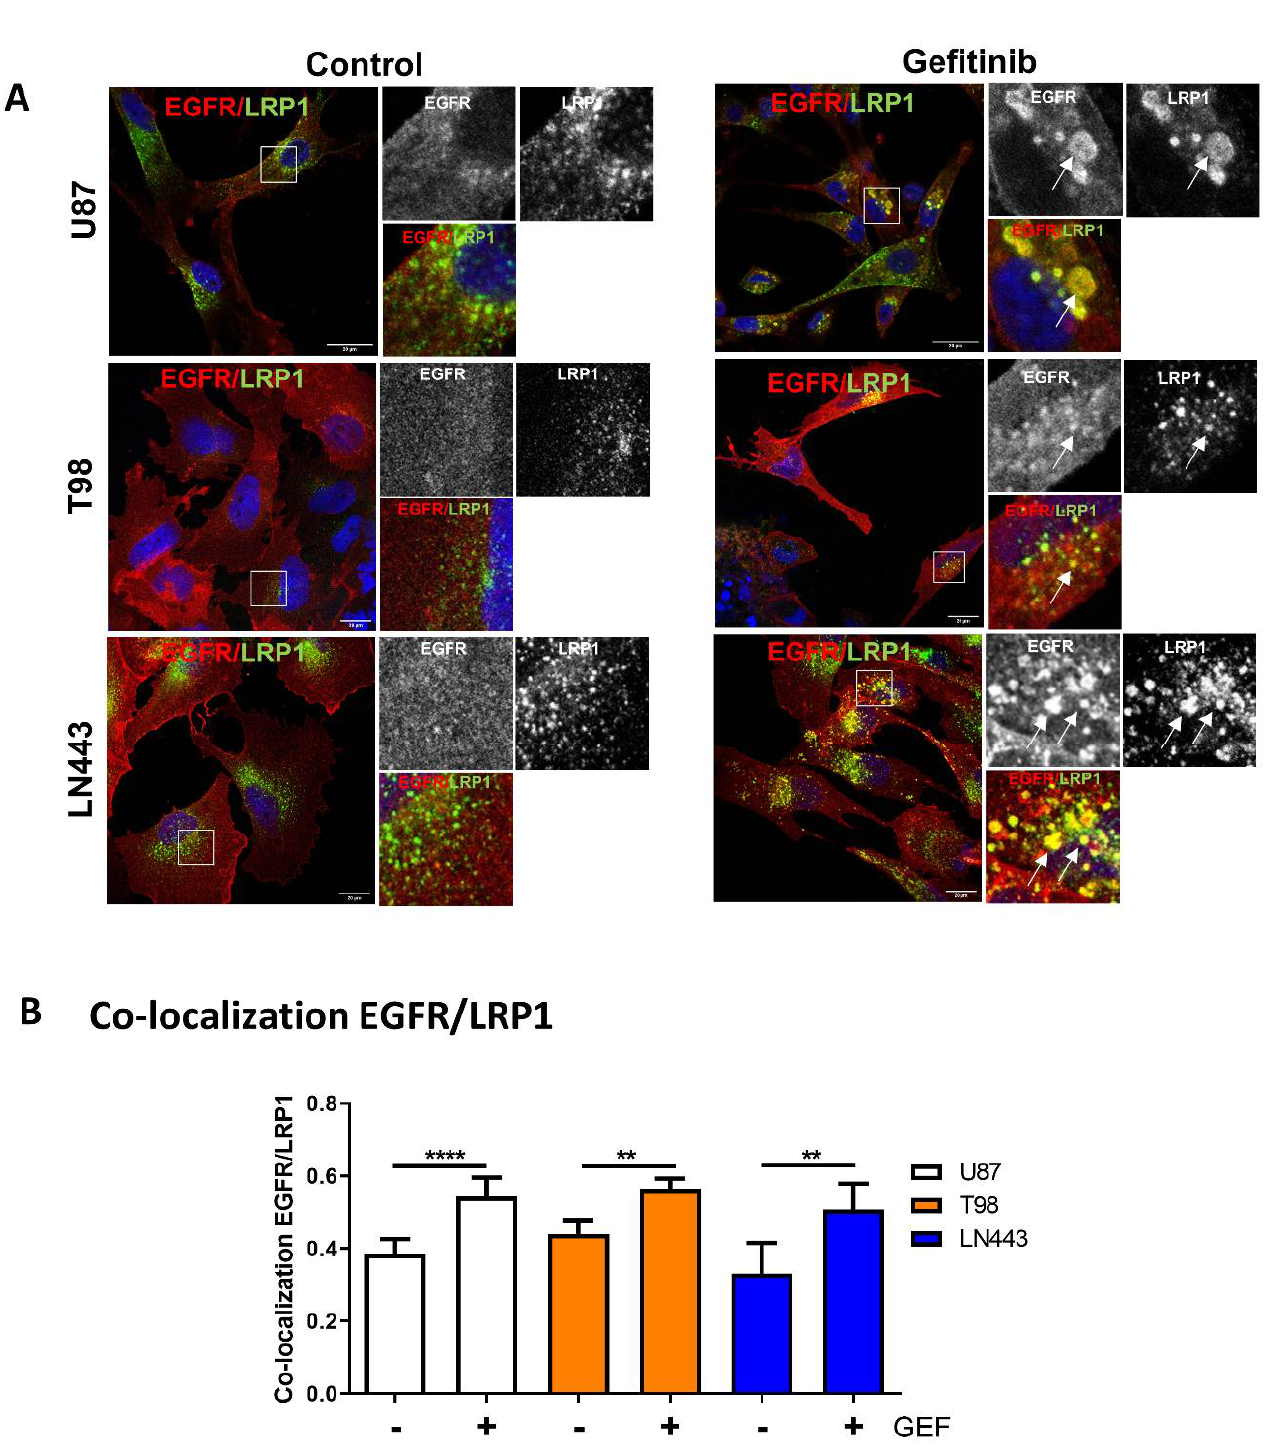
Figure 3. Gefitinib re-localises EGFR on LRP-1-positive endosomes. ( A ) U87, T98 and LN443 two-day-old spheroids were seeded on collagen-I-coated (20 µg·mL −1 ) glass coverslips. After 24 h of treatment with vehicle DMSO (Control) or 20 µM of gefitinib (Gefitinib), spheroids were fixed, EGFR (red) and LRP-1 (green) were immunodetected and analysed by confocal microscopy. Magnified images are from the inserts into the peri-nuclear area, either in single channels or in merged. Arrows indicate GME co-internalised EGFR and LRP-1. Scale bar = 20 µm. ( B ) EGFR/EEA1 co-localisation upon gefitinib treatment was determined using Pearson’s correlation coefficient from 8 images (2–4 cells per images) from 3 independent experiments. Data, reported as column histograms, are the mean with 95% CI ** p < 0.01, **** p < 0.0001. 3.4. LRP-1 Is Involved in Gefitinib-Mediated EGFR Endocytosis